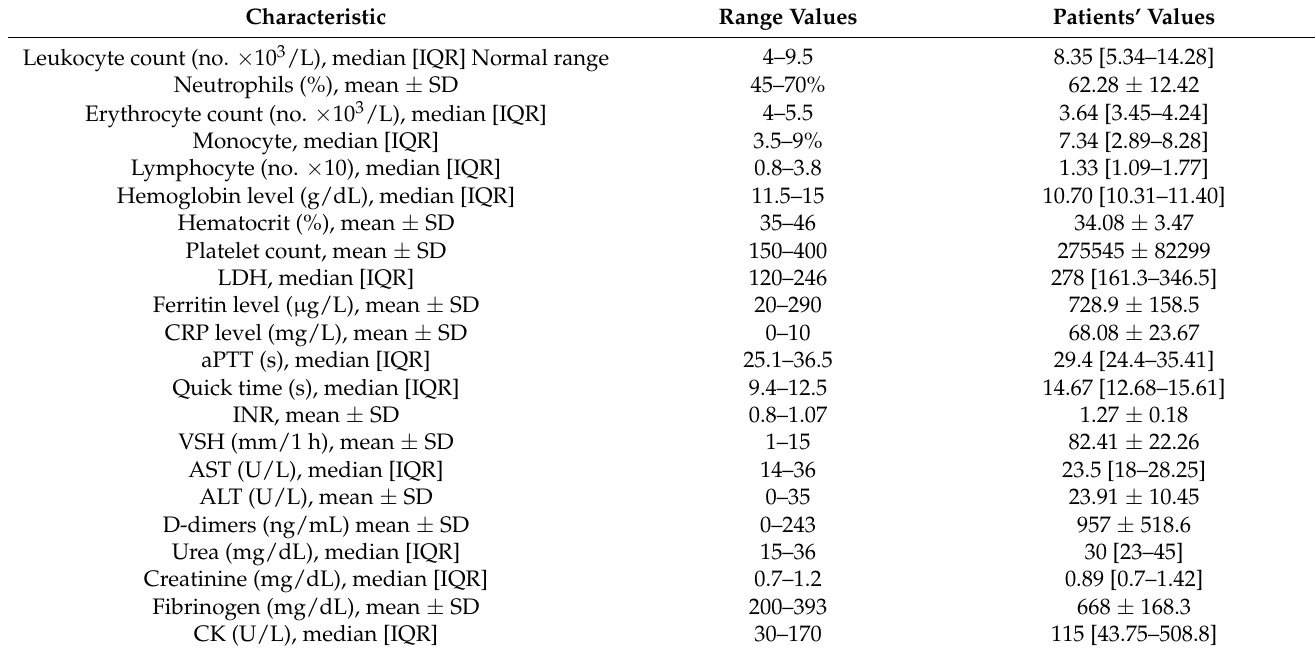
Table 2. Pre-operative blood